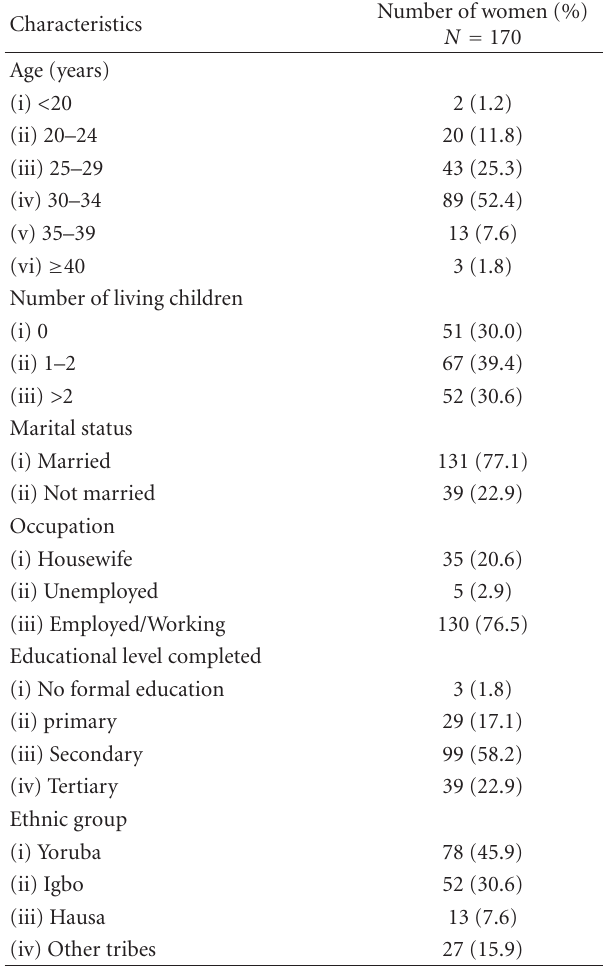
Table 1: The sociodemographic characteristics of the women en- rolled in the